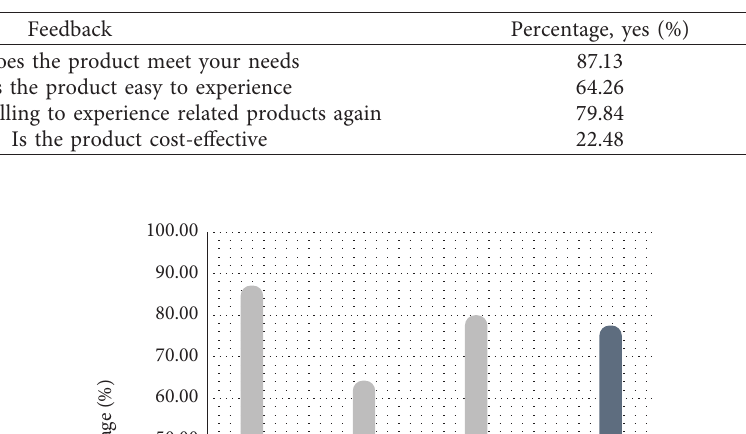
Table 8: Customer